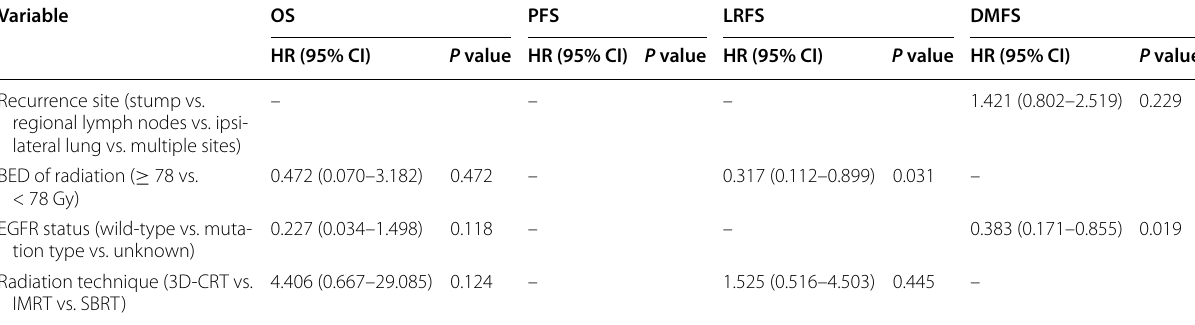
Table 3 Multivariate analyses of prognostic factors for 74 NSCLC patients with postoperative locoregional recurrence treated by radical